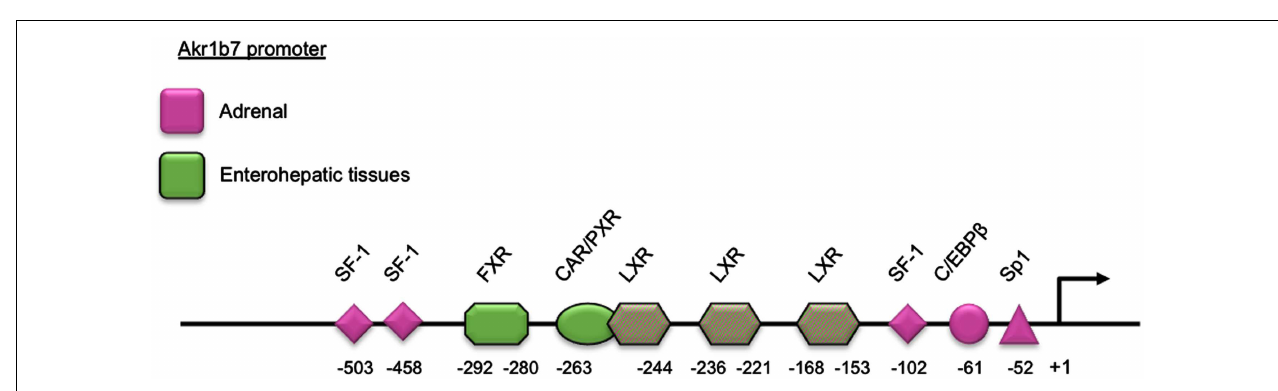
FIGURE 1 | Schematic representation of the Akr1b7 promoter. The DNA binding site for transcription factors and nuclear receptors required for the Akr1b7 specific expression in adrenal gland (pink boxes) and in enterohepatic tissue (green boxes) are shown. LXR binding sites are involved in both adrenal and intestine Akr1b7